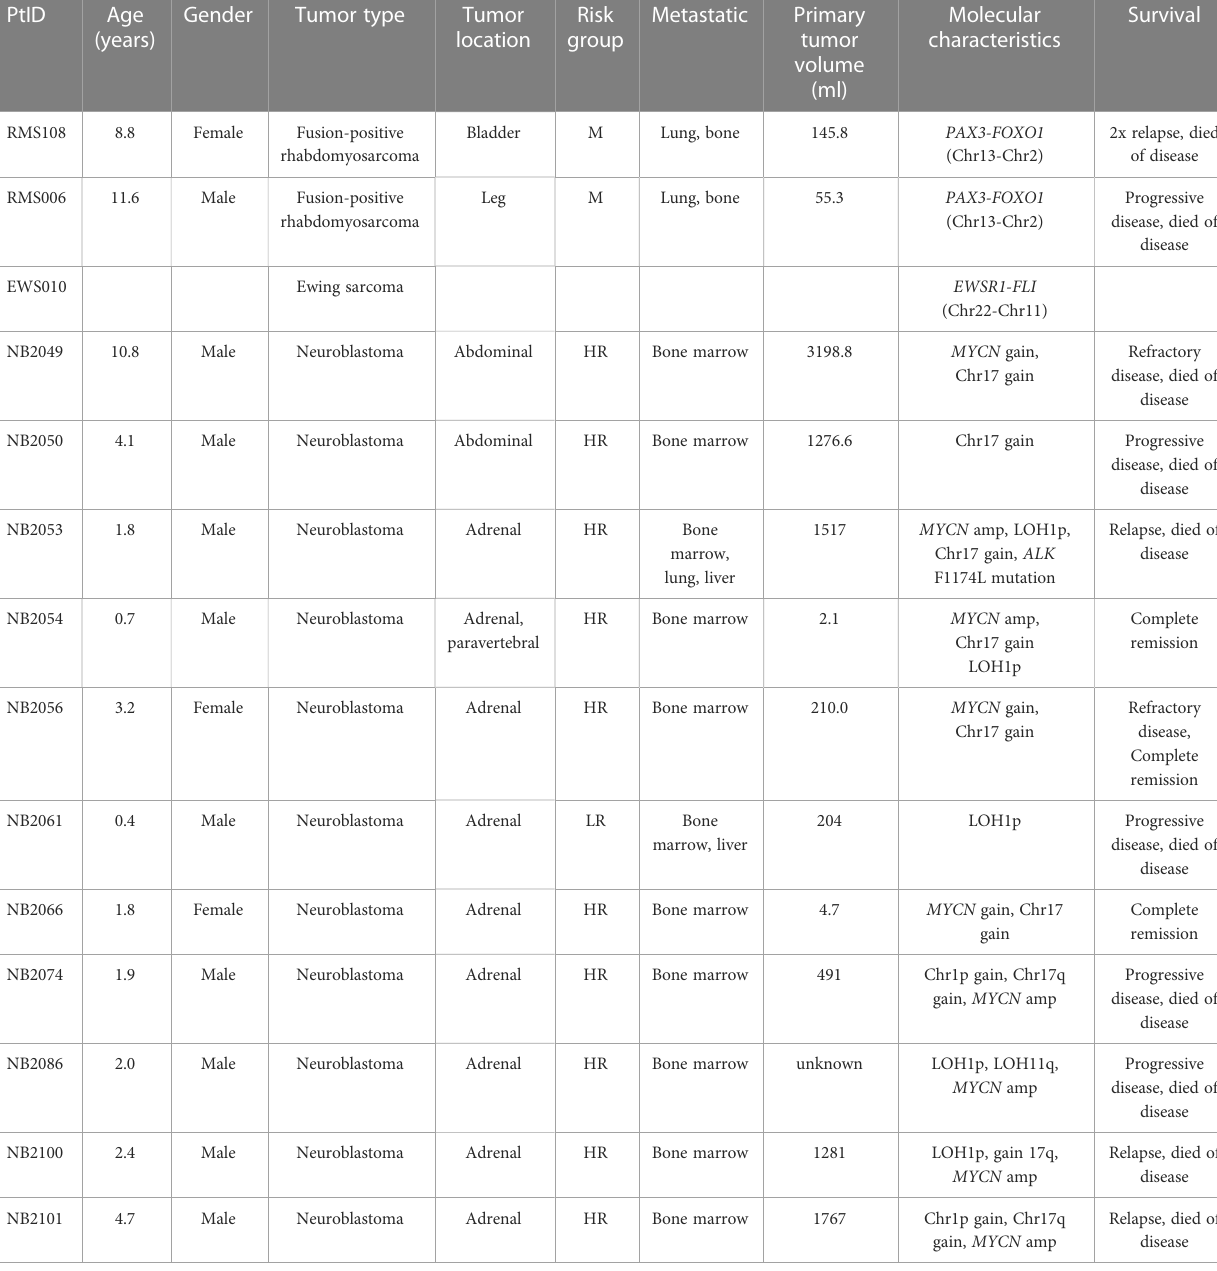
TABLE 1 Clinical characteristics of patients analyzed by targeted locus ampli fi cation (TLA)/capture